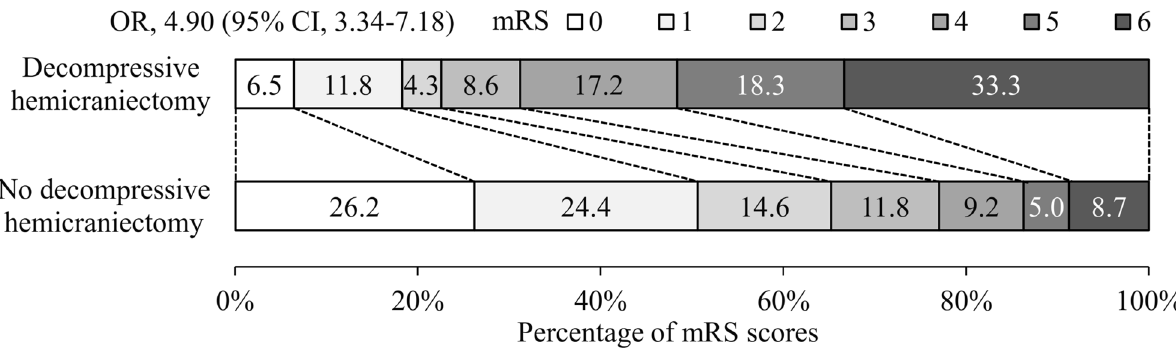
Figure 1. Functional outcomes on the modified Rankin scale at 90 days by groups. The figure shows the distribution of scores on the modified Rankin scale at 90 days with scores ranging from 0 to 6. CI confidence interval, OR odds ratio, mRS modified Rankin